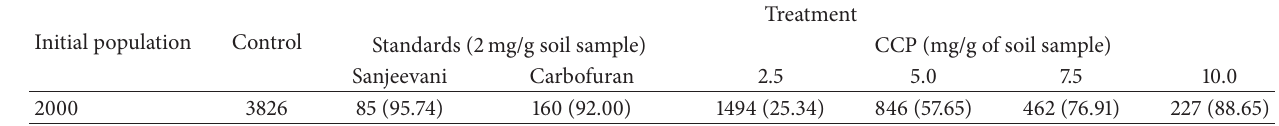
Table 7: Active population of root knot nematodes.